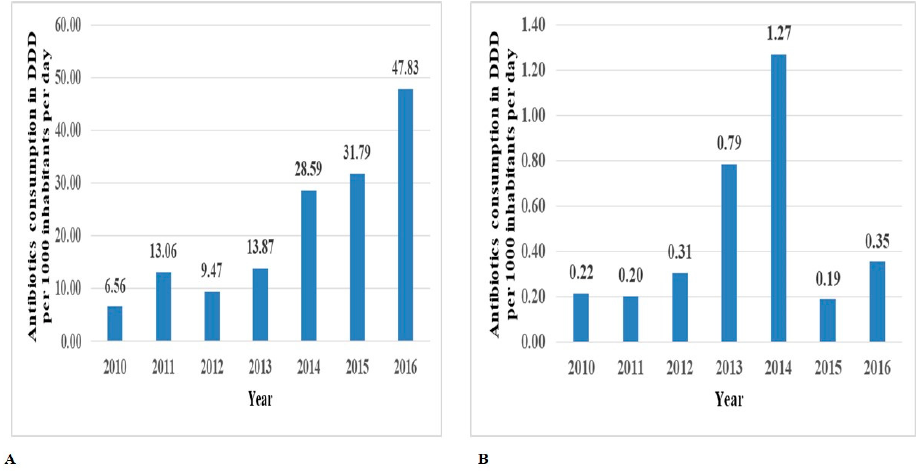
Figure 1. Contribution of oral ( A ) and parenteral ( B ) route of medicine administration for systemic antibiotics utilized over seven years.